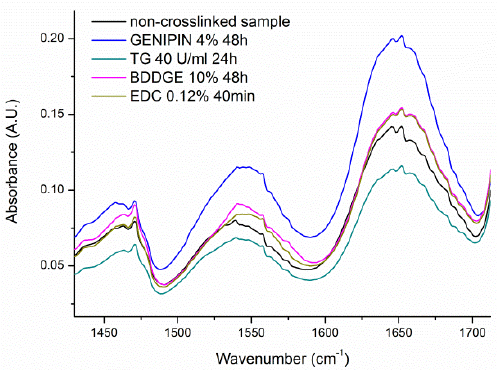
Figure 10. Characteristic FT-IR spectra of PCL/Gt nonwoven samples crosslinked with different methods after biodegradation test (samples in correspondence to SEM analysis). As a control a non-crosslinked sample before biodegradation test was used.